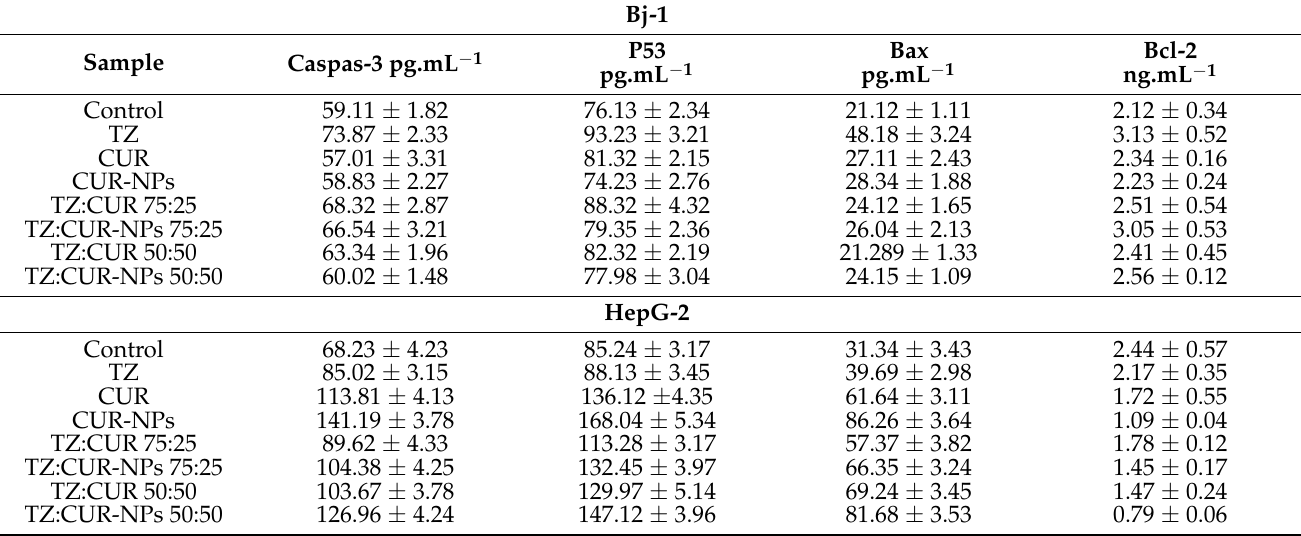
Table 4. Apoptosis marker protein levels in HepG-2 and Bj-1 treated